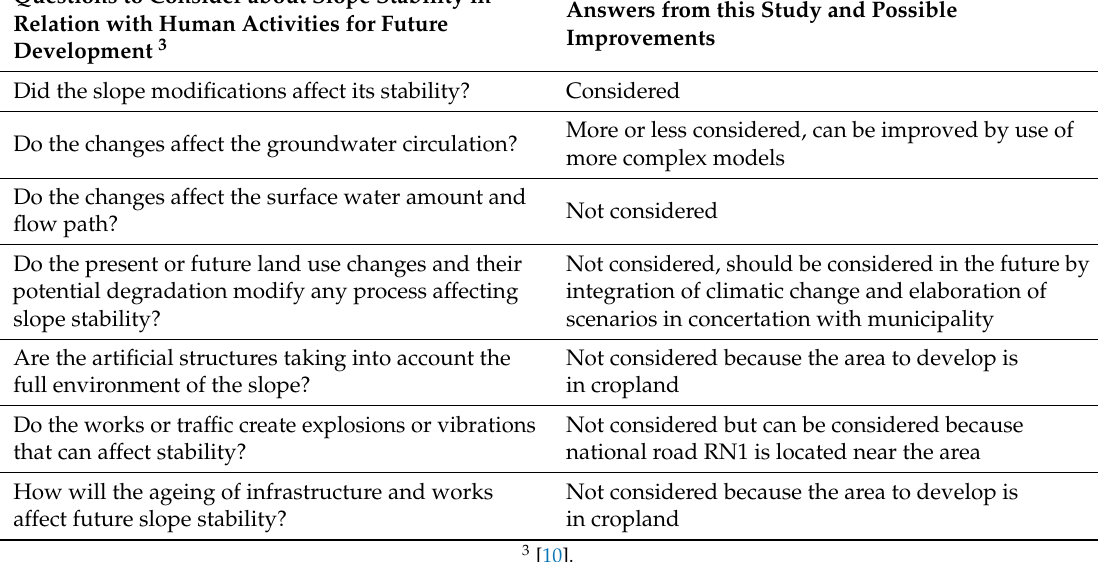
Table 4. The seven questions to ask about slope stability in relation to human activities before